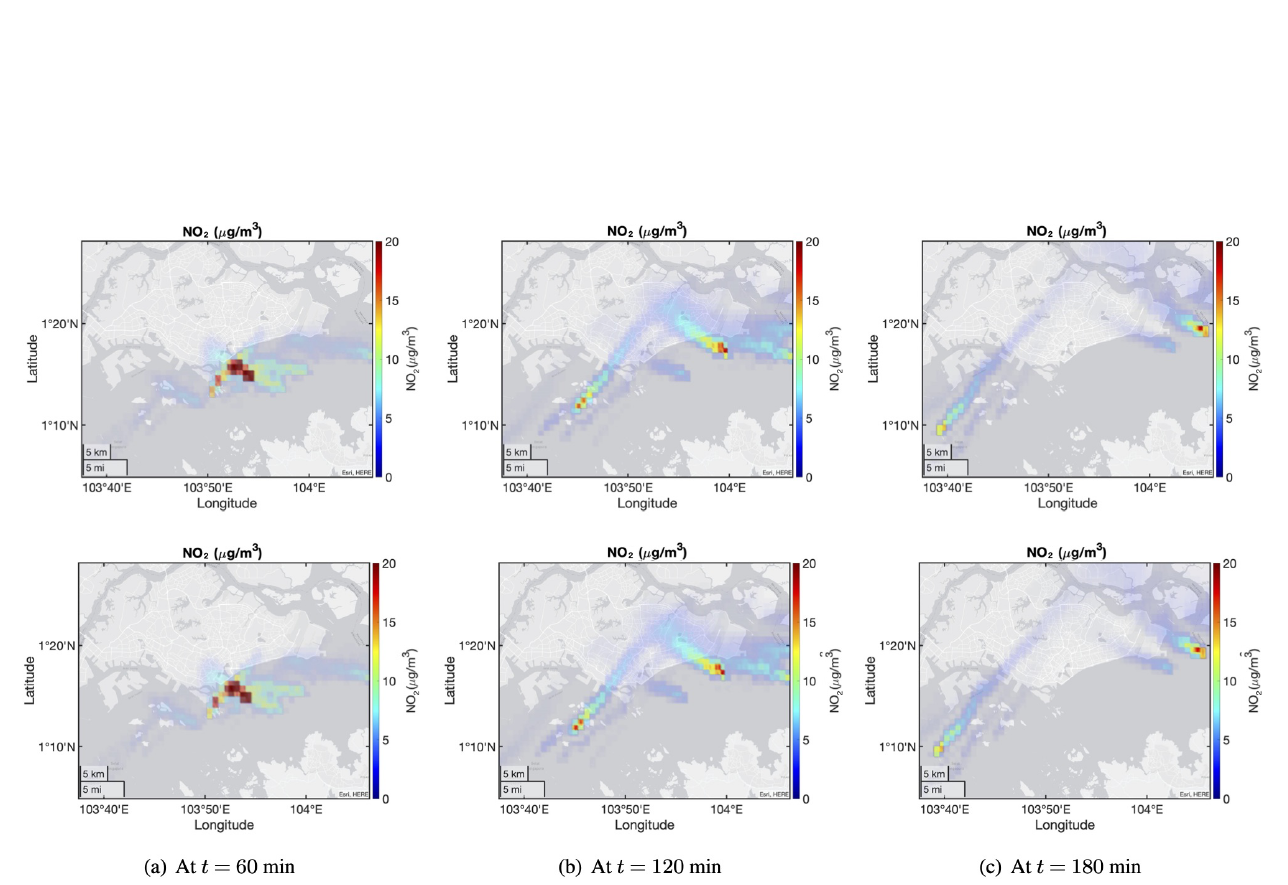
Figure A1. Instantaneous NO 2 concentrations near the ground by using different time steps. Top row: (cid:49)t = 10s (case S1); bottom row: (cid:49)t = 30s (case